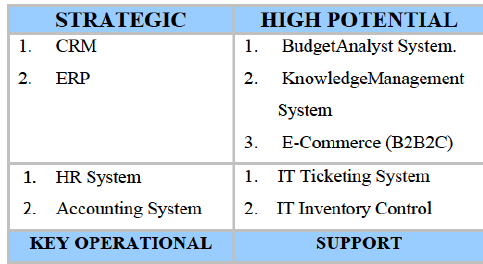
Figure 16: Mcfarlan Grid for Future Application Portofolio